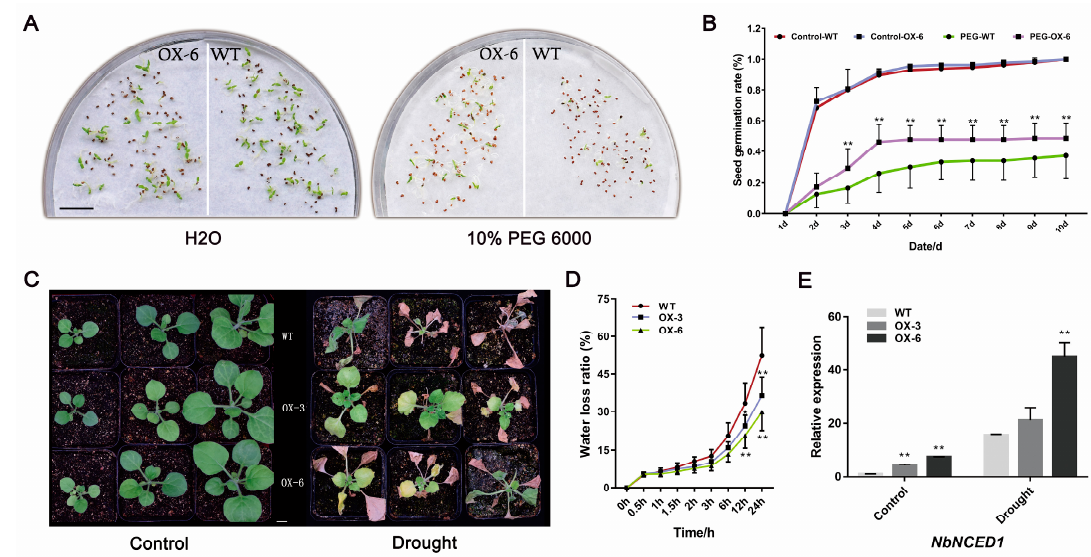
Figure 5. Comparison the rehydration rate of 35S::FaNAC2 and WT lines under drought stress. ( A , B ) Germination rates of 35S::FaNAC2 and WT seeds under water and simulated drought conditions. ( C ) Phenotypes of 40 DAG 35S::FaNAC2 and WT lines under control and rehydration conditions. ( D ) Water loss rate (WLR) of leaves from 35S::FaNAC2 and WT lines. ( E ) The qRT-PCR analysis of NbNCED1 expression, related to ABA biosynthesis pathways. The scale bar represents 1 cm. Bars are means ( ± S.D.) of three independent experiments (Student’s t -test; * p < 0.05; ** p <